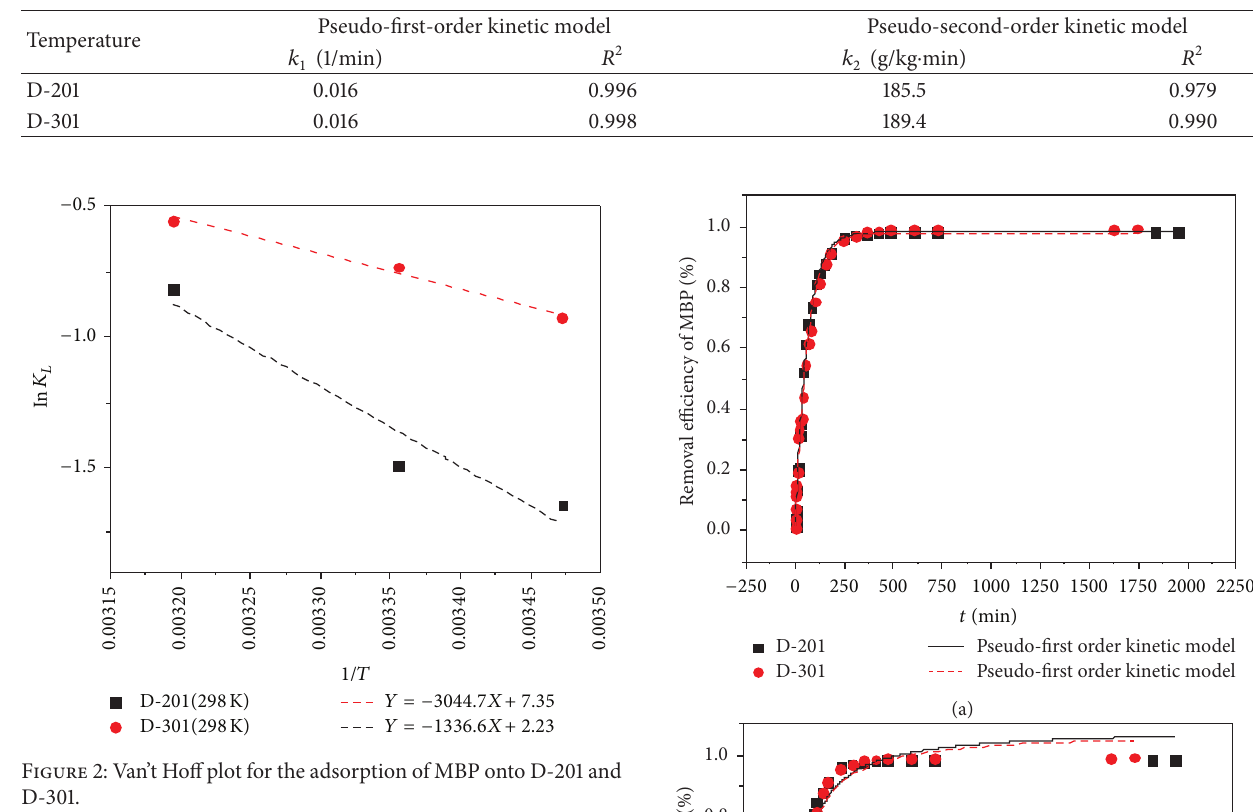
Table 4: Adsorption kinetic parameters of D-201 and D-301.